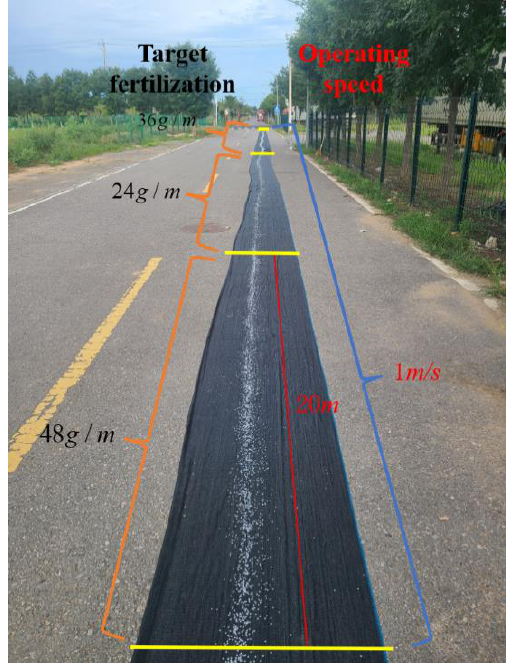
Table 7. Fertilizer discharge precision test of variable-rate fertilization system under different ferti- lizer discharge amounts.